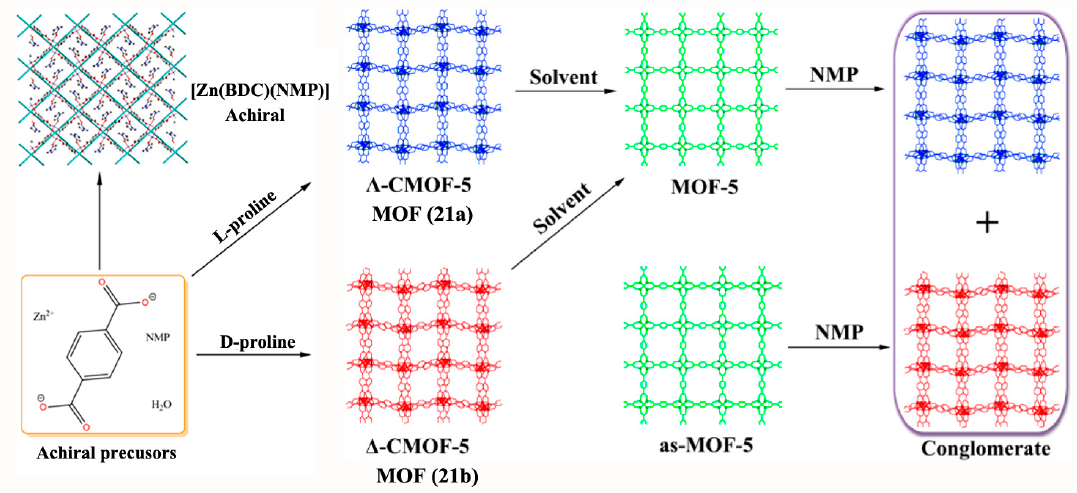
Figure 9. Synthesis of CMOF-5 in the presence of L - or D -proline additives induces chirality and post-synthetic activity of the achiral solvent N -methyl-2-pyrrolidone (NMP). Reproduced from [85] with permission from the American Chemical Society.